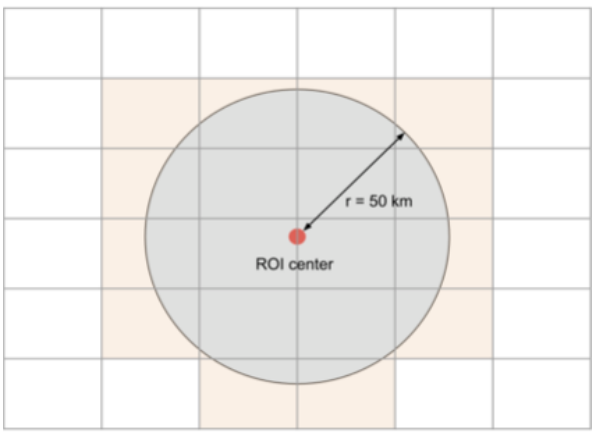
Figure 18. Spatial colocation principle for Earth observation data. All gridded observations within or intersecting a 50km radius from the ROI centre for all the consecutive files within ± 5d around the ROI centre time are averaged together. The mean and other statistics (median, standard deviation, minimum, maximum and interquar- tile range) are also calculated and provided in the output matchup